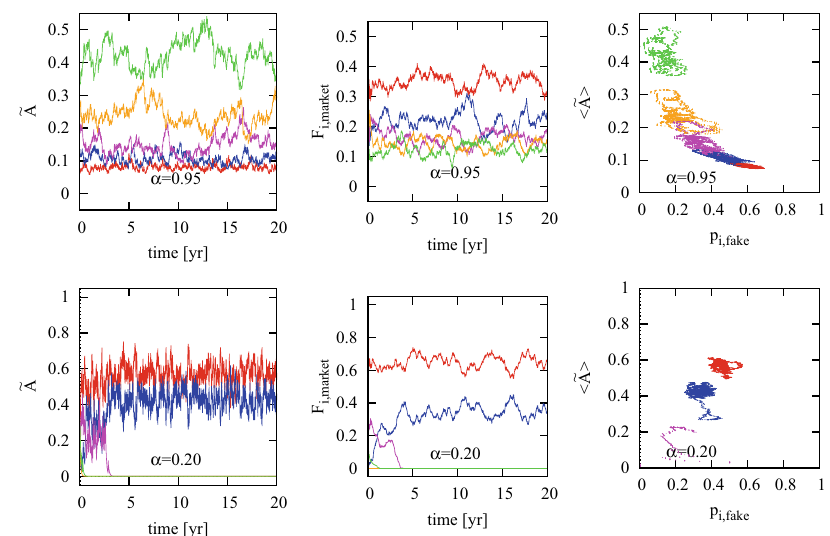
Fig. 8 Same as Fig. 7 but for five media outlets with editorial standards μ 1 = 0 . 15, μ 2 = 0 . 3, μ 3 = 0 . 45, μ = 0 . 6 and μ = 0 . 75, represented in red, blue, magenta, orange, and green, respectively. The top panels 4 5 consider α = 0 . 95 and the bottom panels α = 0 . 2 (color figure